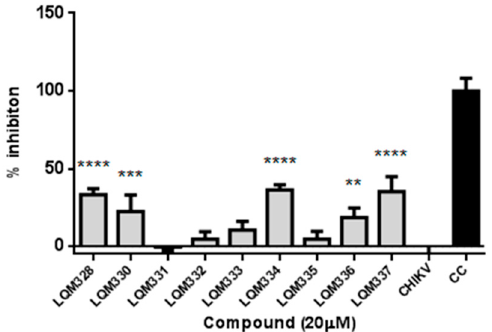
Figure 5. In vitro screening of anti-Chikungunya virus activity of acrylamides. The virus adsorption was performed for 2h followed by the addition of tested compounds at 20 µM concentration. The cell viability was assessed after 48h and the viral inhibition (%) was determined for each compound. The expressed values result from the mean ± SD of triplicates. CHIKV = CHIKV-infected untreated cells. CC = uninfected cellular control. ** p ≤ 0.01; *** p ≤ 0.001; **** p ≤ 0.0001 versus CHIKV.